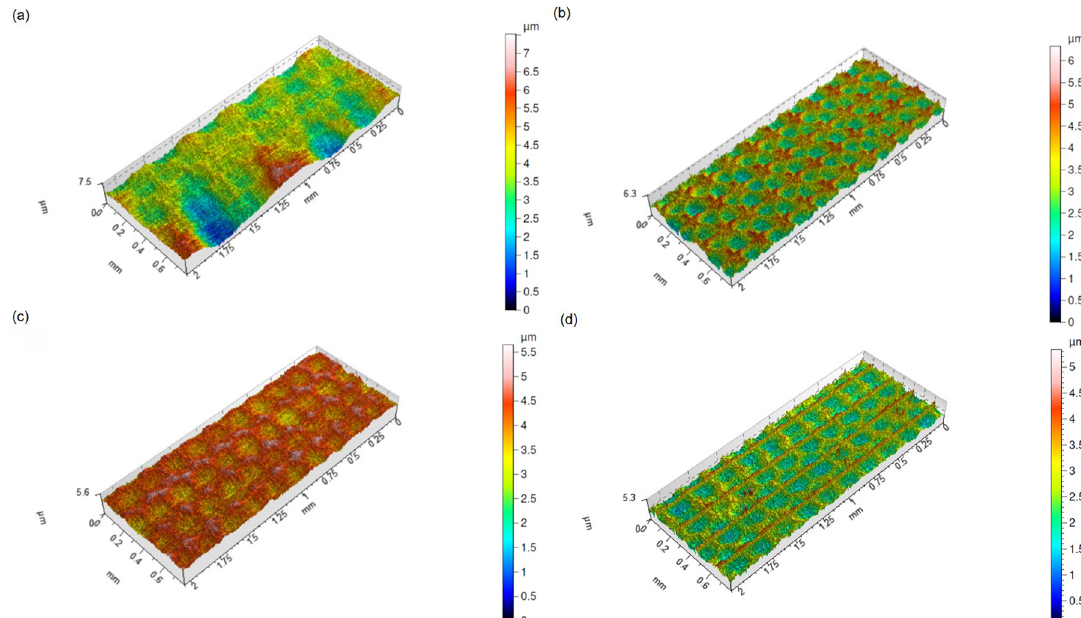
Figure 5. Surface topographies generated by horizontal tool path orientations at inclined workpiece angle of 15º (a) HUD, (b) HUU, (c) HDD, (d)